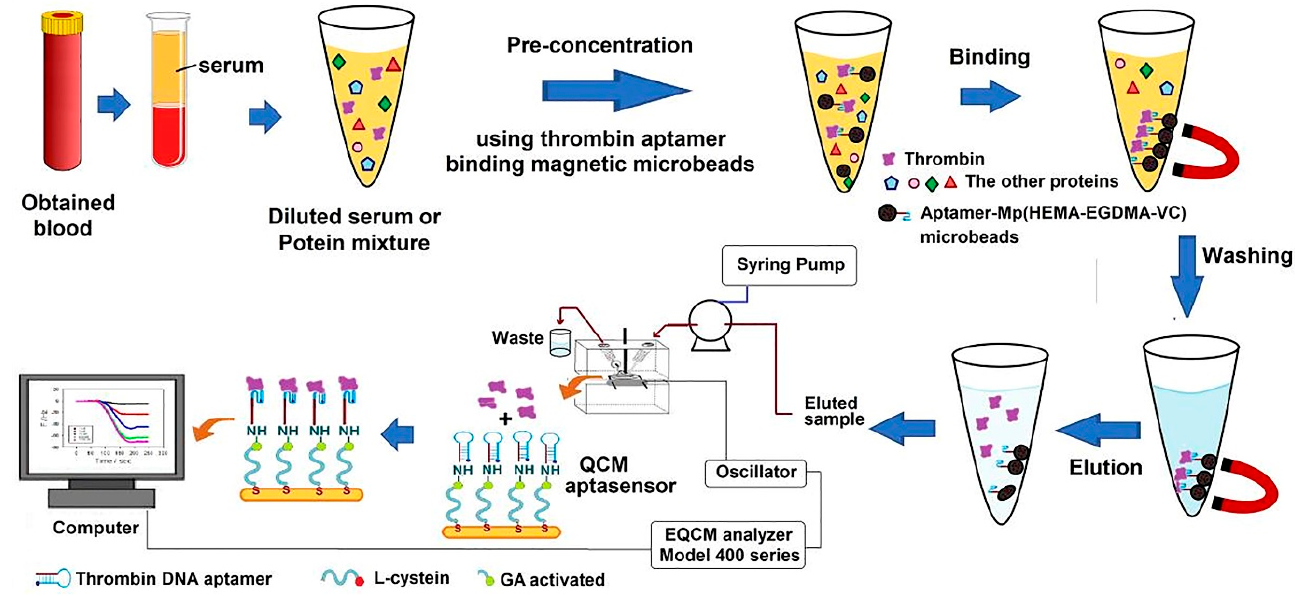
Figure 10. The process for TB determination by using a QCM-aptasensor [174].